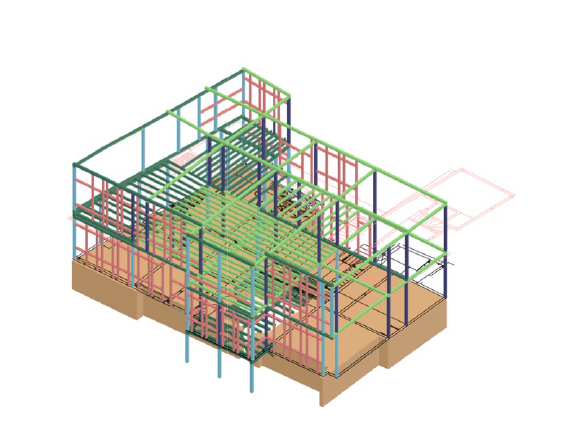
Figure 4. 3D Structural Model with Identified